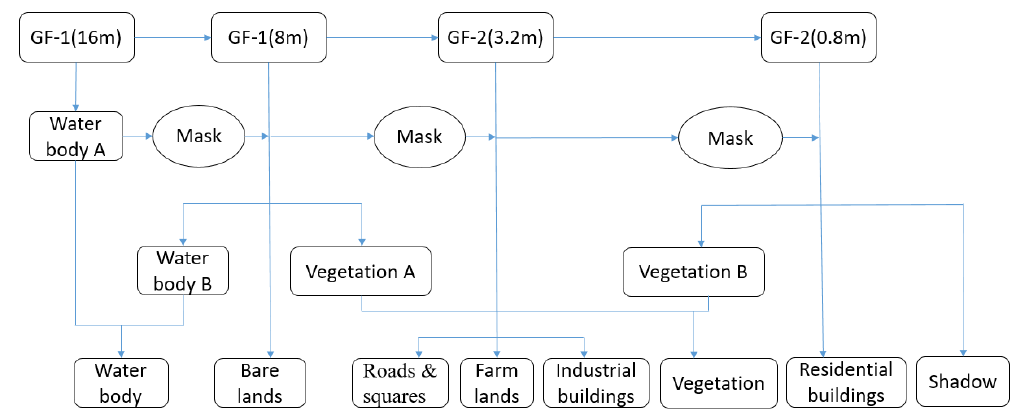
Figure 4. Flowchart of information combination from GF-1 and GF-2 multi-resolution satellite imagery.